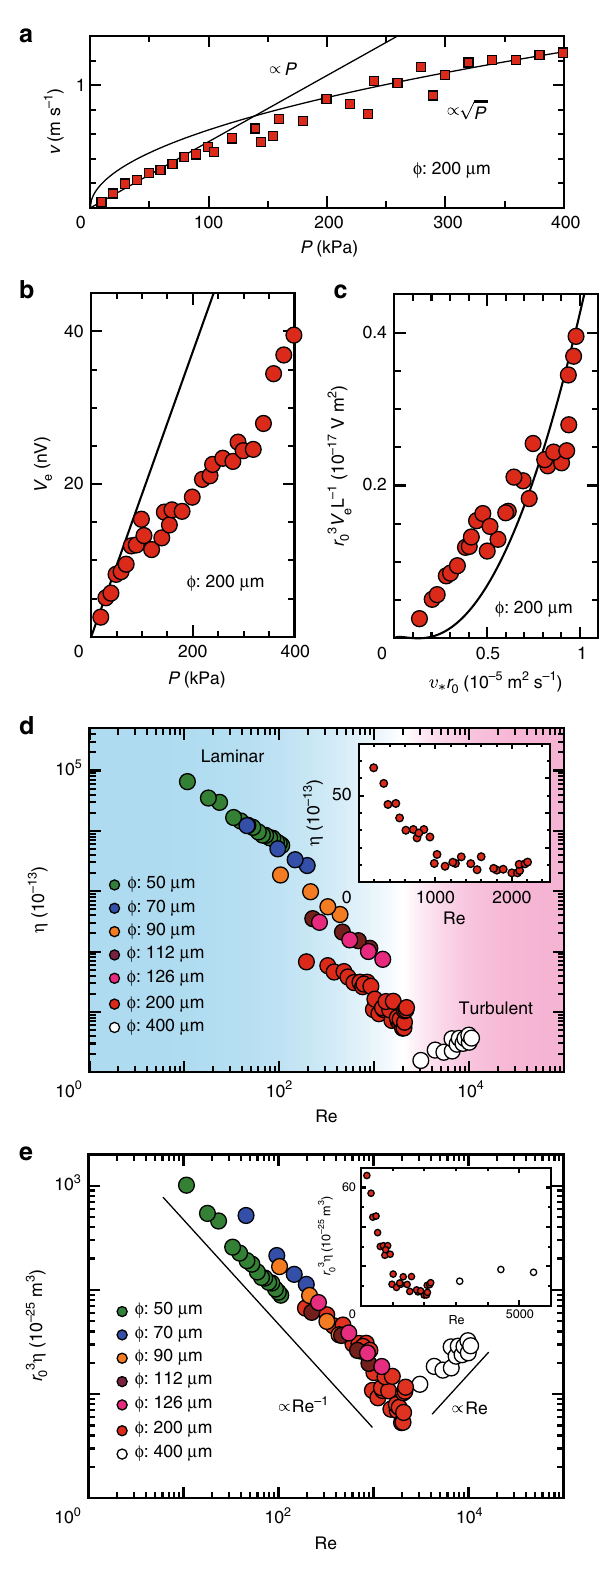
theory of the laminar and turbulent fl ow, respectively, and that the SHDG voltage continuously changes from the laminar behavior to the turbulent one with changing Re across the tran- sition fl ow regime.